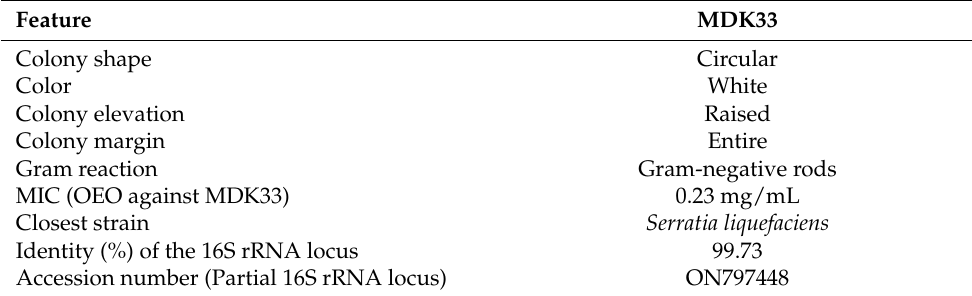
Table 1. Some characteristics of MDK33.